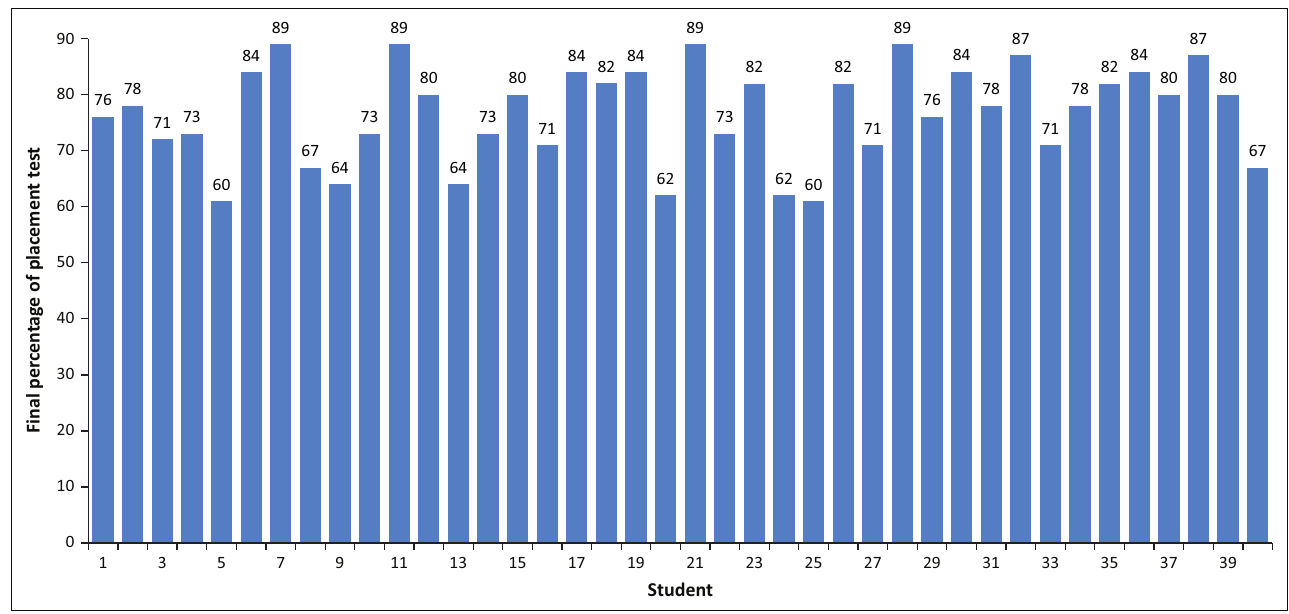
FIGURE 5: Participants who consider reading a hobby subsequent to attending the intermediate programme.